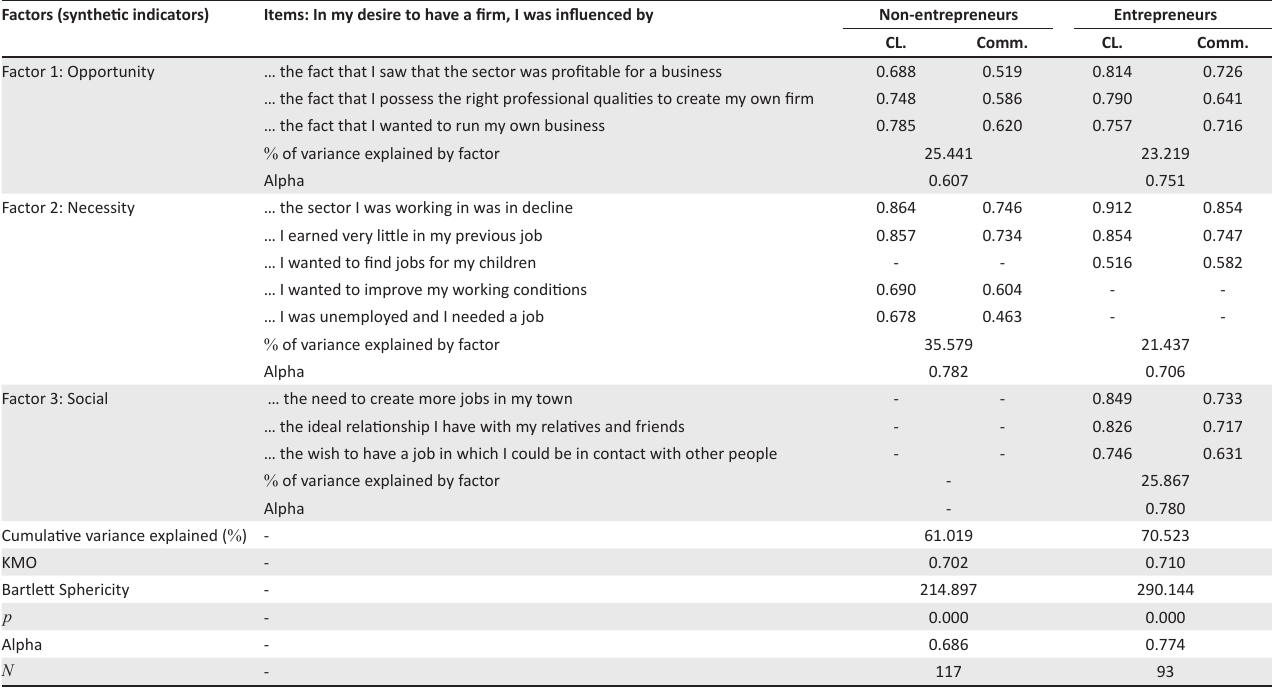
TABLE 1-A1: Entrepreneurial Motivation Scale. Configuration matrix from SPSS Pc 17.0: Non-entrepreneurs and entrepreneurs subsamples. Factors (synthetic